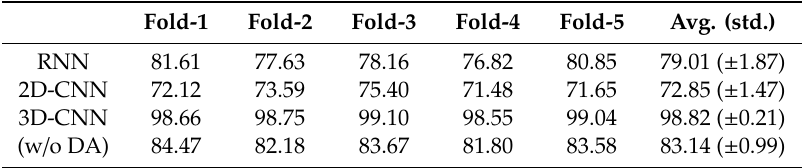
Table 2. Accuracy (%) comparison per fold and the average of the proposed hand gesture recognition system with other machine learning-based systems using the target domain dataset.